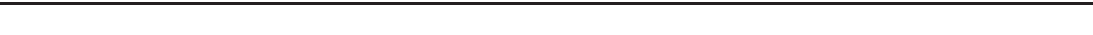
Psychological distress